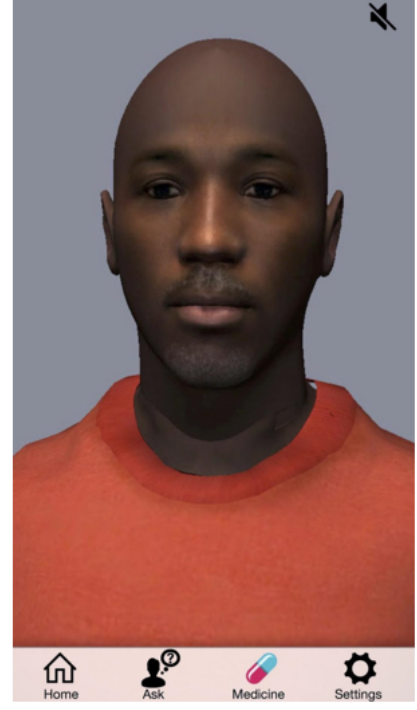
Figure 1. Proposed initial appearance of the avatar shown to focus group participants at the first focus